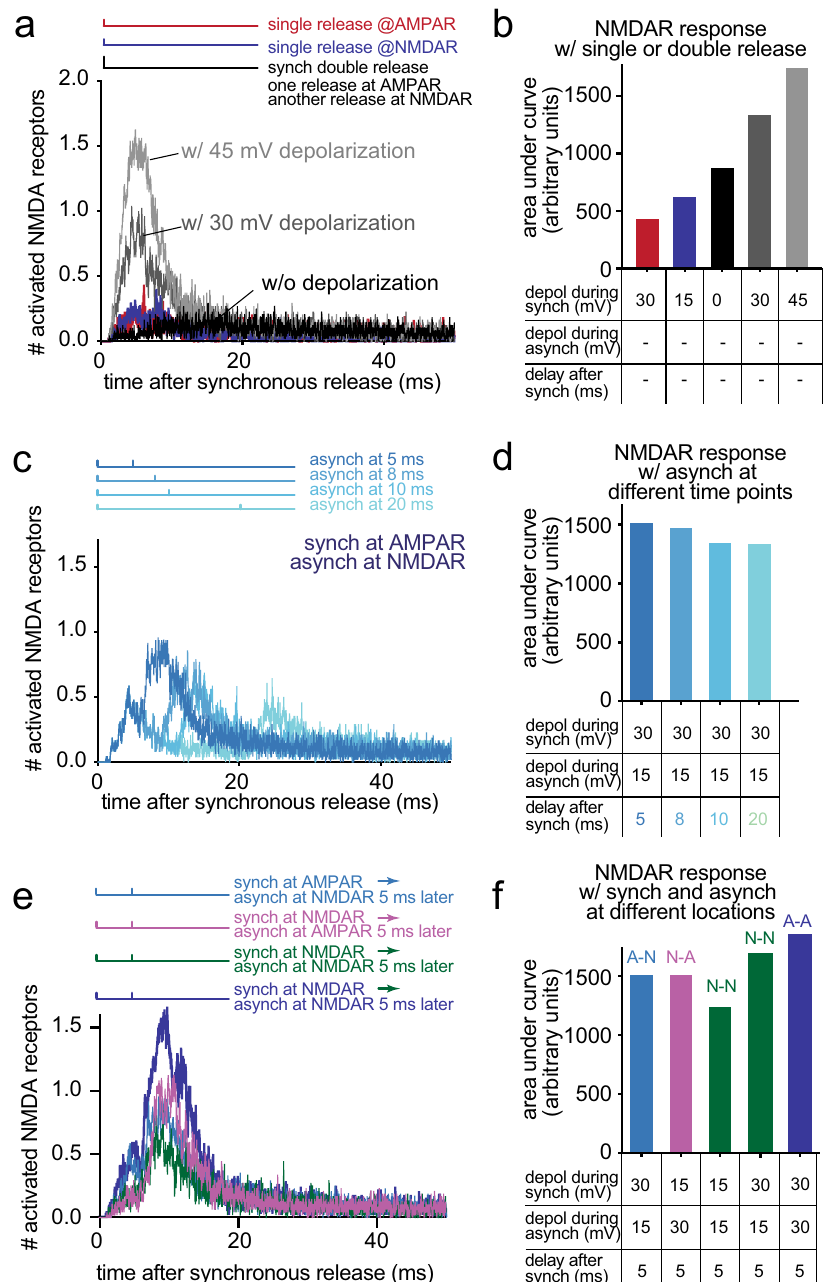
Fig. 4 Computer simulations predict better activation of NMDA receptors with asynchronous release. a Time course of simulated NMDA receptor activation, resulting from one or two release events at the indicated locations while varying the degree of depolarization of the postsynaptic membrane. The number averaged from 48 simulations is plotted. The vertical lines in the diagrams shown above the plot indicate when synchronous and asynchronous release occur. Synchronous release always occurs at time 0. Double release means two release events happen simultaneously. Synch synchronous, Asynch asynchronous. b The area under curve calculated from each data set in ( a ) and plotted as a bar graph. The locations of release are described in ( a ), and the degree of depolarization (depol) and the delay between synchronous and asynchronous release used in simulations are listed at the bottom. c Same as ( a ), but varying the interval between two release events. d Same as ( b ), but plotted from each data set in ( c ). e Same as in ( a ), but varying the order of the release. f Same as in ( b ), but plotted from each data set in ( e ) and plotted as a bar graph. A-N: synchronous release at AMPA receptors and